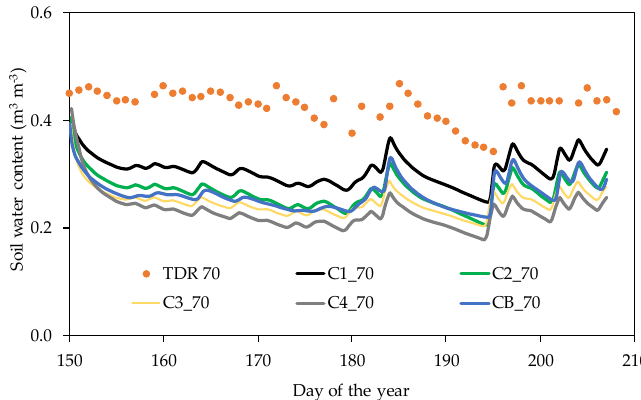
Figure 5. Comparison between measured and simulated soil water content at a 70-cm depth resulting from the five approaches.